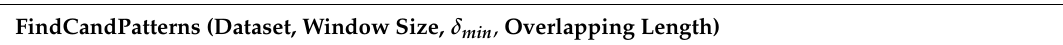
Algorithm 1. FindCandPatterns